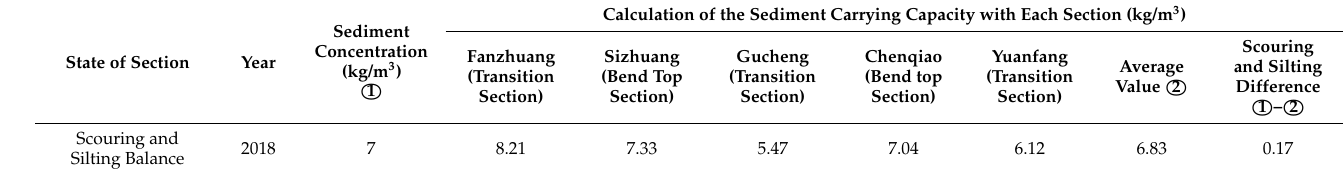
Table 9. Verification of scouring and silting state of each section after the construction project (800 m 3